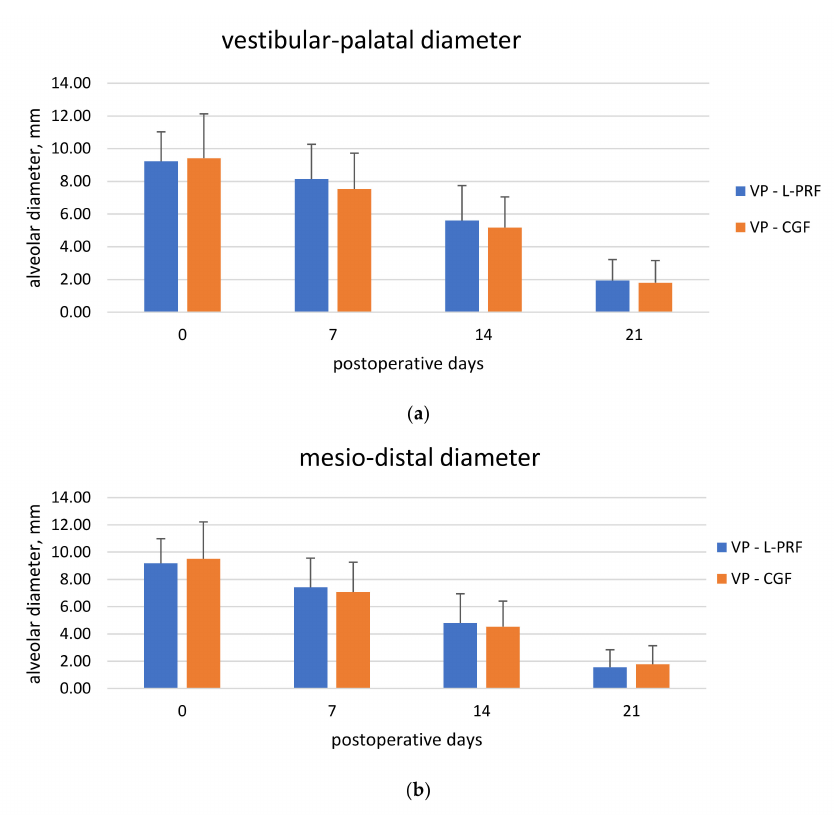
Figure 2. ( a ) Alveolar diameter in the vestibular-palatal dimension; ( b ) Alveolar diameter size in the mesio-distal dimension.